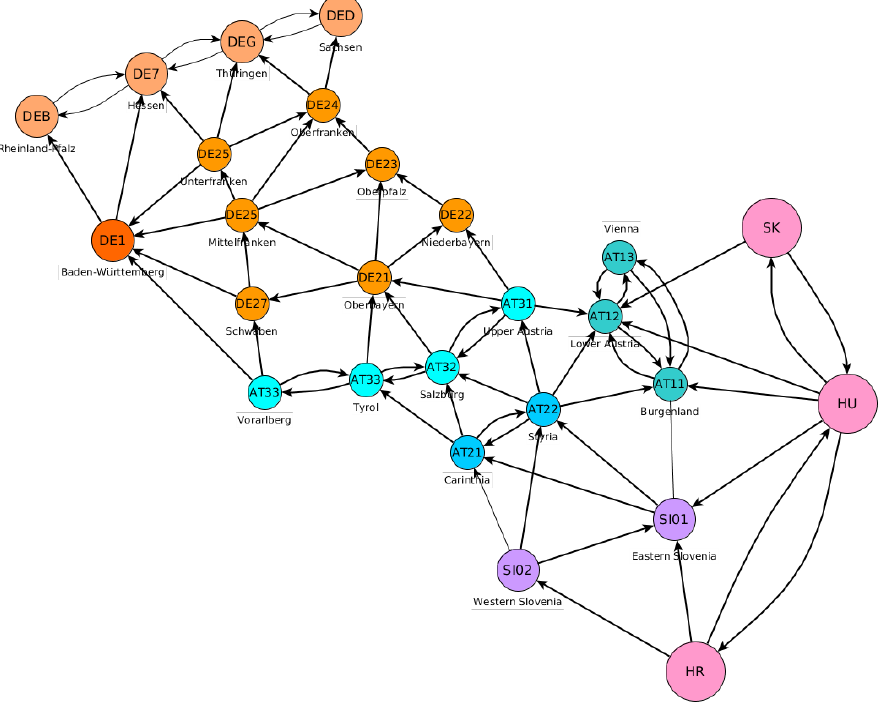
Figure 23. A visualisation of a possible resulting graph obtained from the NUTS hierarchy and distance information of OSM.